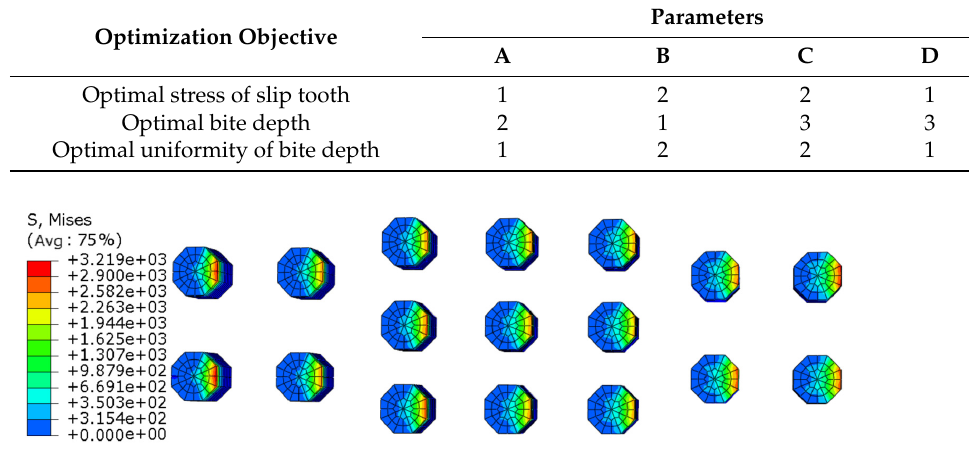
Figure 18. The stress of slip tooth (after optimization).